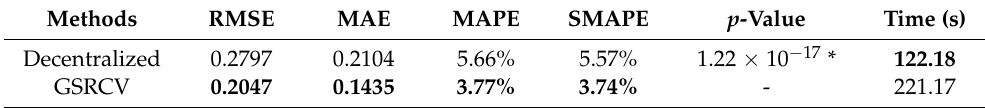
Table 4. Average accuracies of different parameter optimization methods.